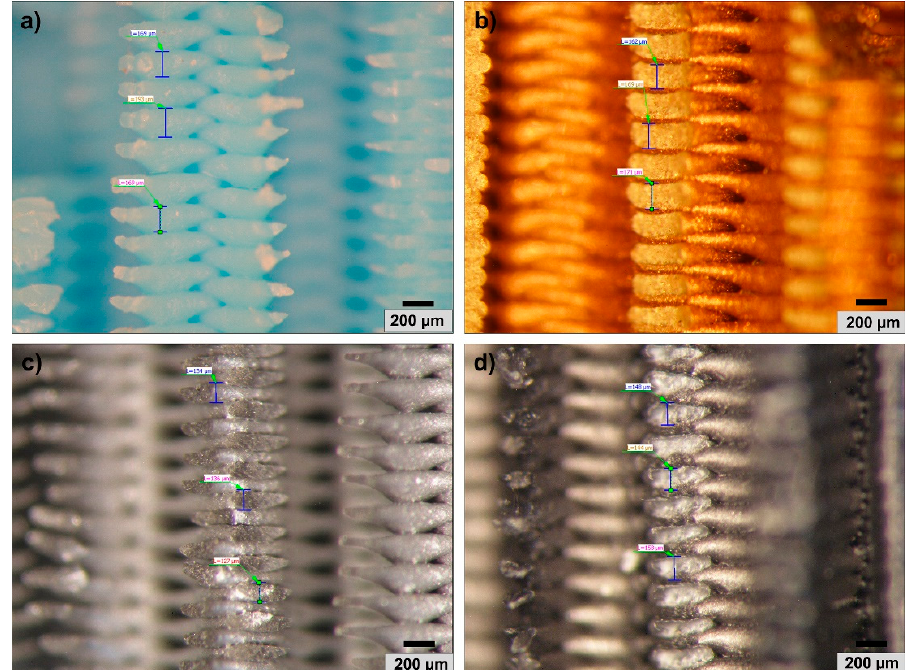
Figure 8. Macrostructural aspect at stereomicroscope of experimental samples in transversal cross section, with 60% interior fill percentage and 45° thread deposition: ( a ) polylactic acid material; ( b ) polylactic acid material with copper particles; ( c ) polylactic acid material with aluminum particles; ( d ) polylactic acid material with graphene particles.